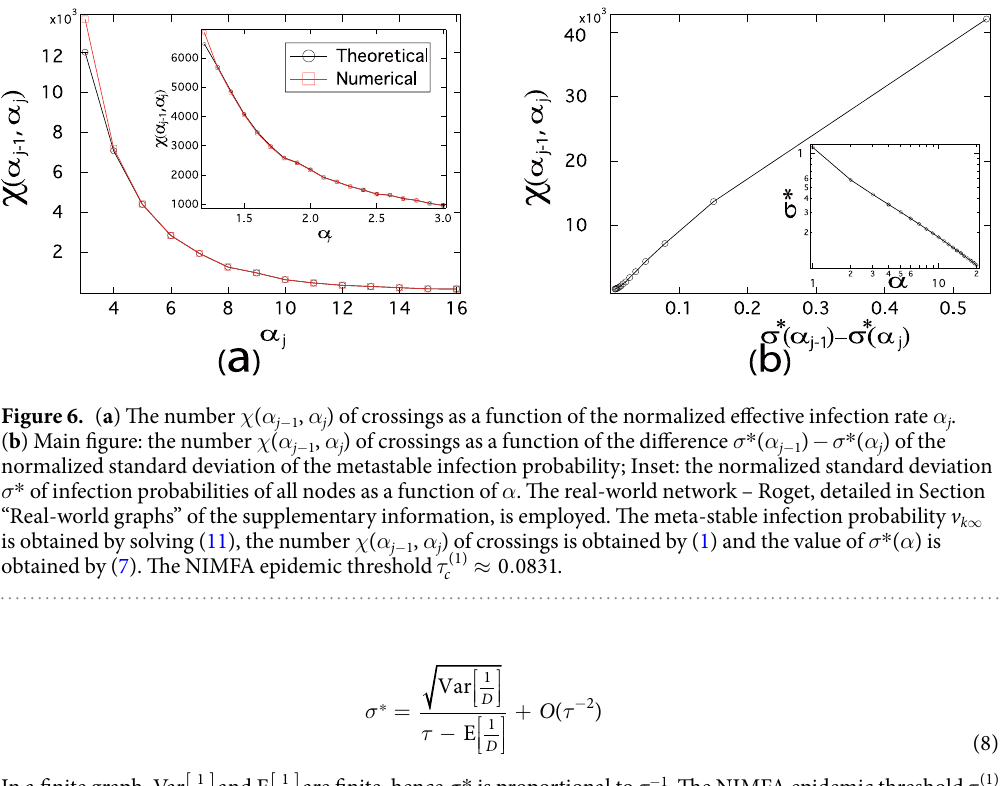
  1  1  (1) − 1 . The NIMFA epidemic threshold τ In a finite graph, Var  and E D  are finite, hence σ * is proportional to τ   c D 1 1 (1) , we obtain that σ * is proportional to α − 1 . Although the is a constant for a given graph, and with α τ τ = − − c power-law relationship between σ * and α can be clearly observed in Fig. 5, the effective infection rate τ corre- sponding to the variable α in this figure may be smaller than 1 and the theoretical proof is only valid when the  1 and Var  1 are effective infection rate  1 τ . Our result (8) is based on connected graphs, because the terms E       D D undefined in unconnected graphs with isolated nodes. The power-law decay of the variable σ * with the effective infection rate τ explains why there are more cross- ings when the effective infection rate is smaller. Validation on a real-world network. Finally, we validate our previous findings on the real-world network – Roget, detailed in Section “Real-world graphs” of the supplementary information. As shown in Fig. 6(a), the